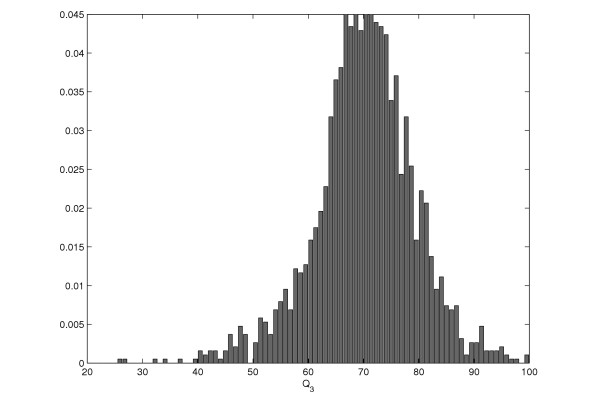
Distribution of the prediction accuracy, Q3(%), over different amino acid sequences in the dataset.